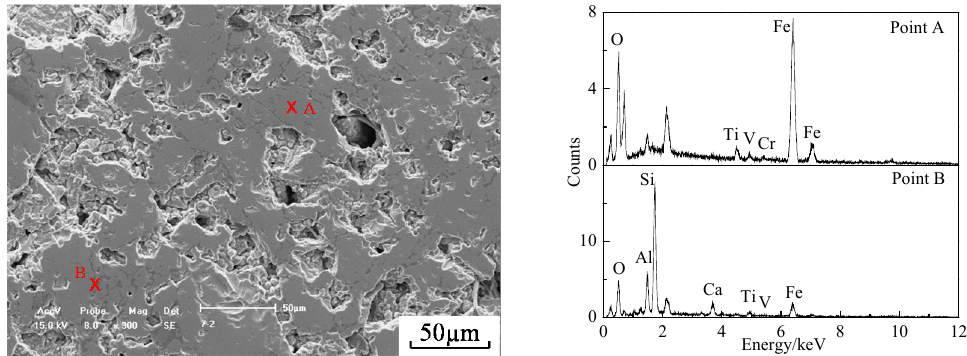
Figure 9. Scanning electron microscopy-energy dispersive spectrometer (SEM-EDS ) analysis of the oxidized HCVTM pellets (A — gray phase; B — dark gray phase).